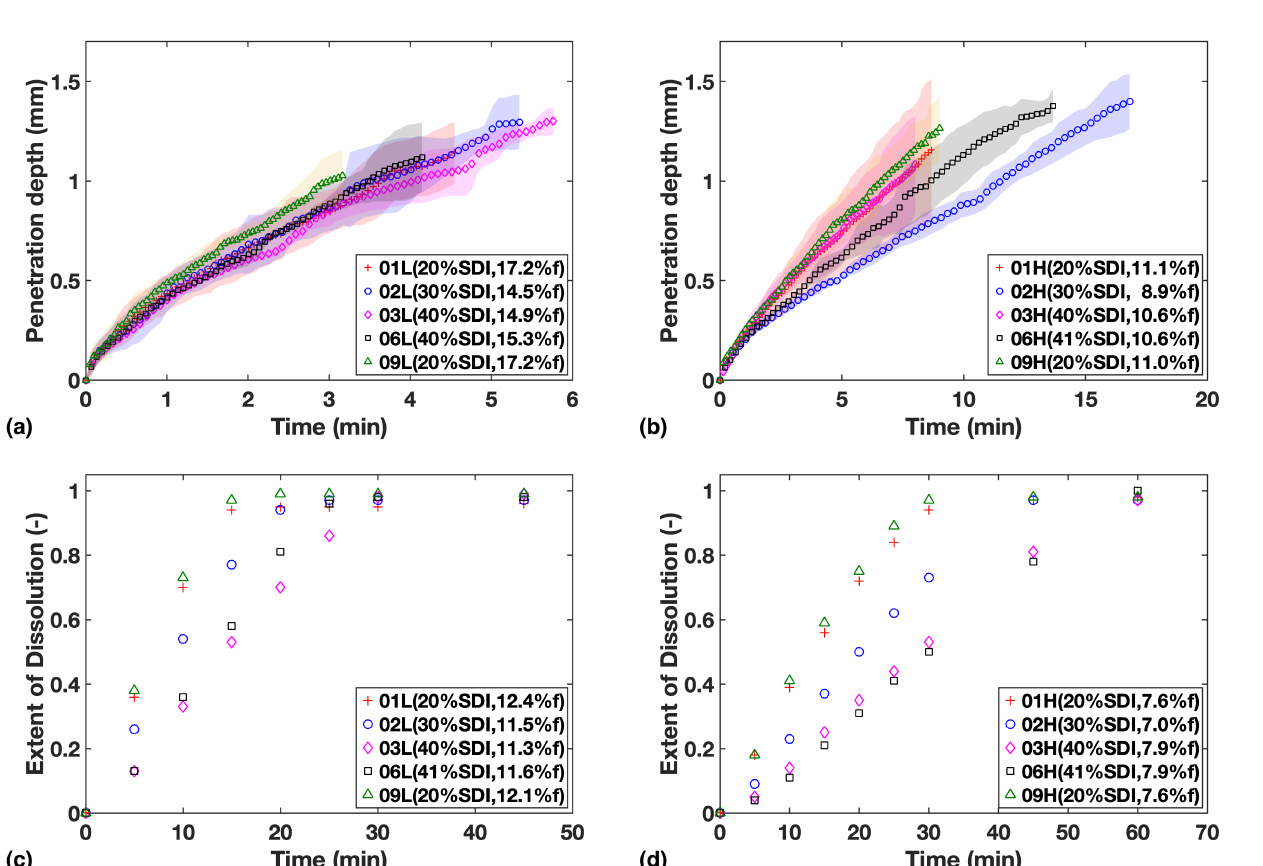
Figure 2. Study 1—Liquid penetration vs. time from TPI data for ( a ) Low compaction batches ( b ) High compaction batches, which is to be compared with USP dissolution profiles for ( c ) Low compaction batches ( d ) High compaction batches. Mass fraction of SDI and mean batch porosity labelled in the